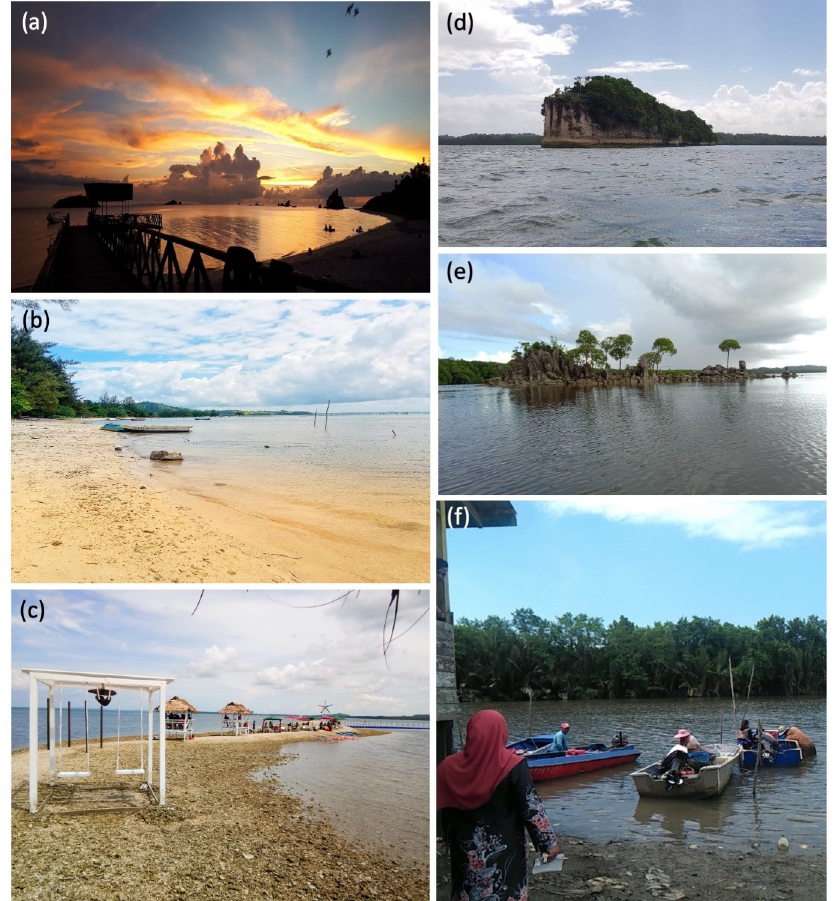
Fig 6. Photographs portraying sociocultural aspects of participants’ life associated with cultural services. (a) This scenic view of sunset makes the shore at Banggi Island an attraction for domestic and international tourists. (b) This shore at Banggi Island is where fishers dock their boats and families do recreational activities. (c) This Floating Coral Bar near Malubang is a tourist destination in TMP. (d) Supirak Island is a rock island that has a local folklore and potential for tourism. (e) Batu Berunsai, which is another rock island near Malubang, is a tourist destination and is related to a local dance. (f) An isolated community residing in mangroves near Marudu Bay that should be shared with knowledge of sustainable natural resource